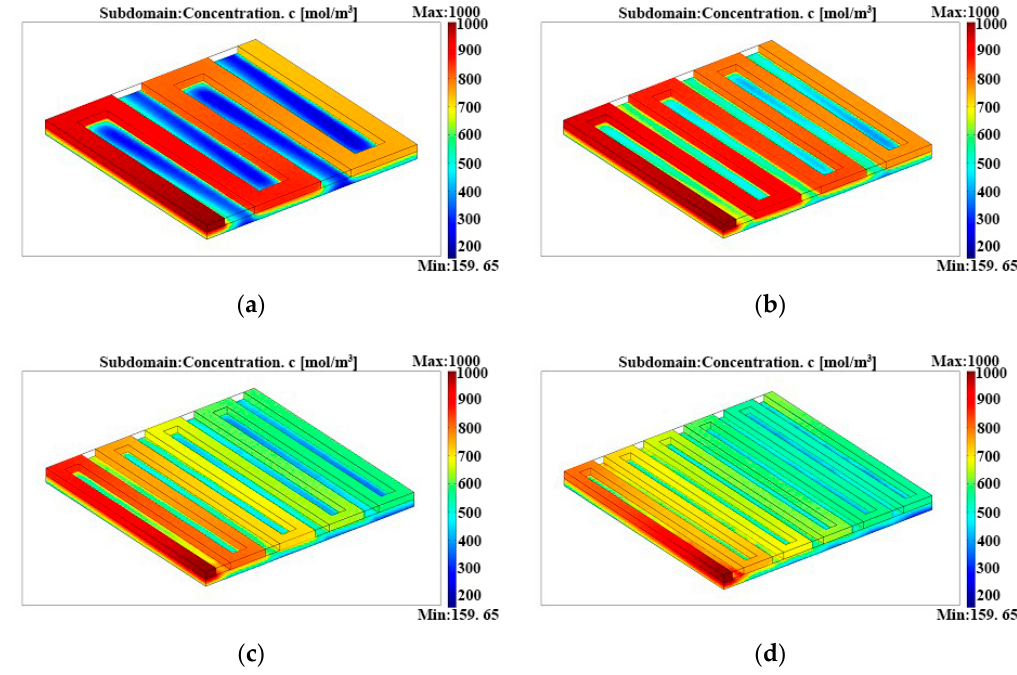
Figure 8. Methanol concentration distributions in the anode serpentine flow fields with different channel lengths: ( a ) channel length = 47.32 mm, ( b ) channel length = 63.50 mm, ( c ) channel length = 79.60 mm, and ( d ) channel length = 96.03 mm.